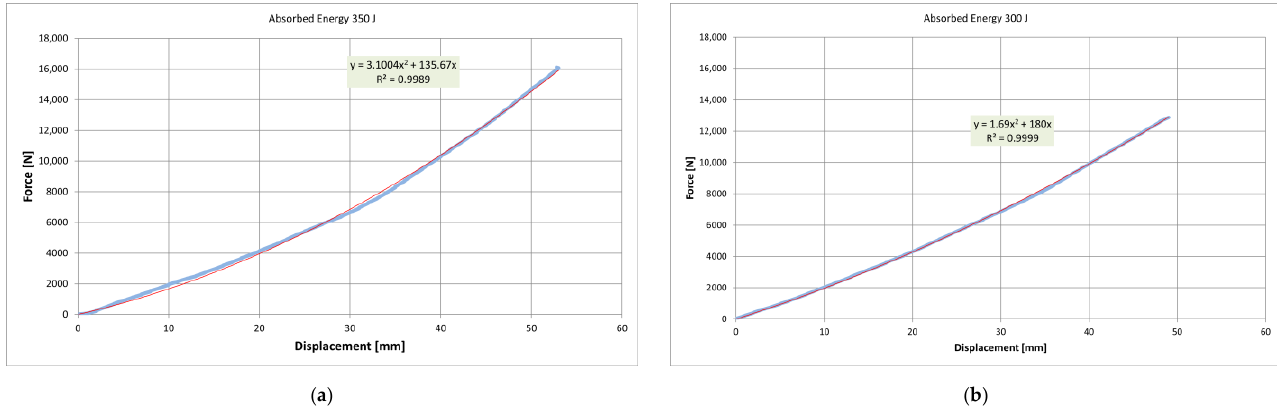
Figure 9. Effective silent-block force-displacement characteristics for static tests performed on: ( a ) Load cell (C1); ( b ) Load cell (C2). Blue is the measured result and red is the best fit quadratic forced through the origin.